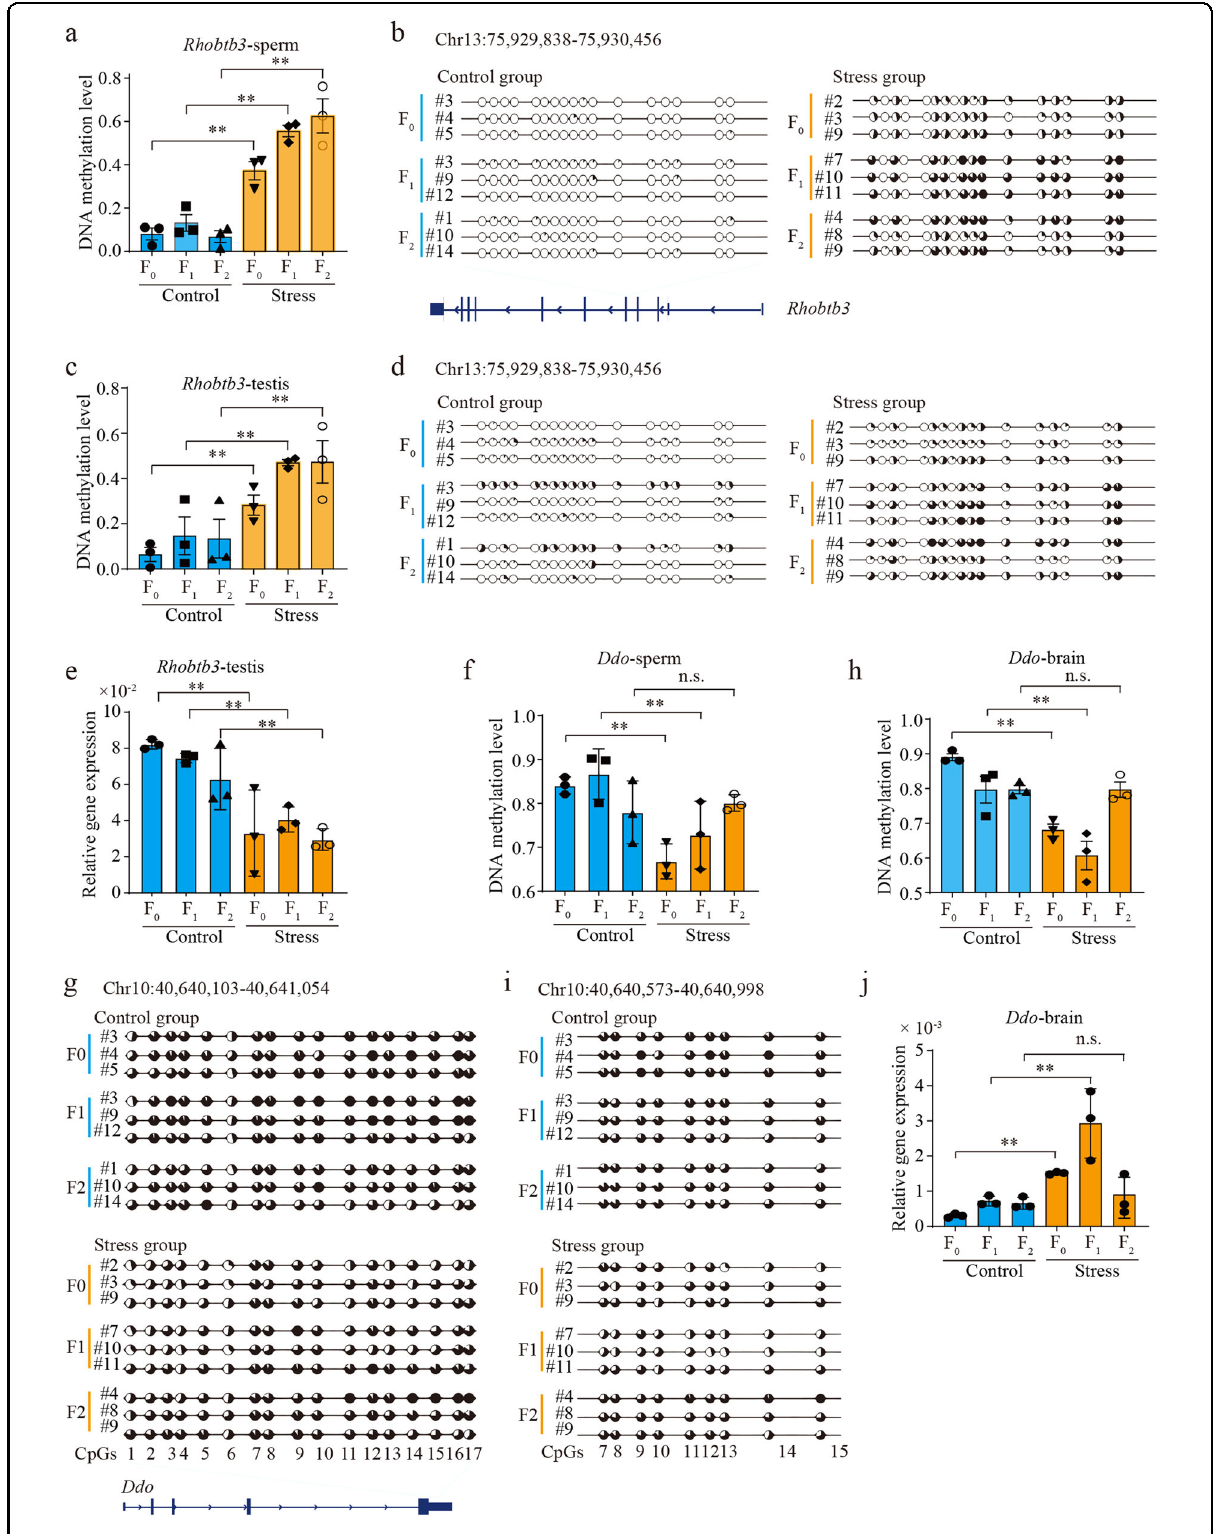
Fig. 4 (See legend on next